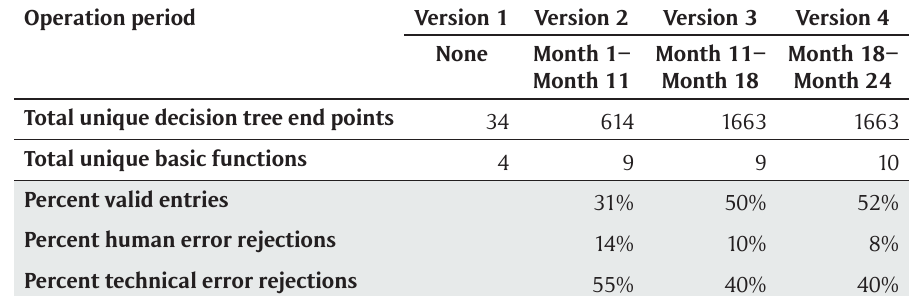
Table 2: Changes that have occurred within the 4 versions of the Prey Lang App in Prey Lang, Cambodia, 2015–2017. Shown are the number of unique decision tree end points available; the number of unique basic functions used (i.e., push button, drop down menu, camera, audio recording); the percentage of valid entries; the percentage of entries rejected due to human errors; and the percentage of entries rejected due to technical errors within the operation period for the associated version of the app. See also Appendix 1B, supplemental materials.